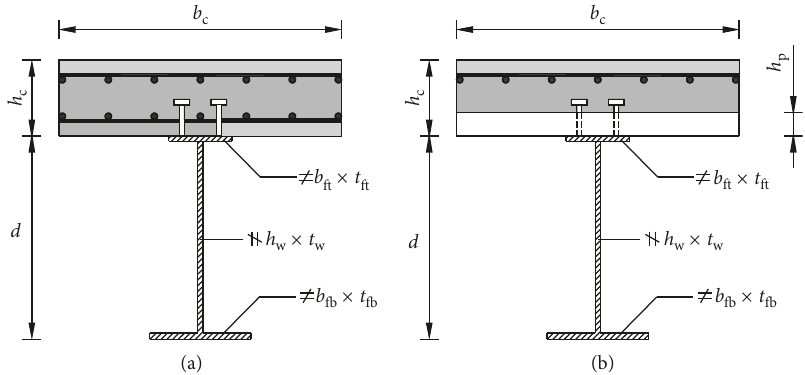
Figure 1: Typical cross sections of composite beam with (a) full concrete slab and (b) composite slab (on profiled steel